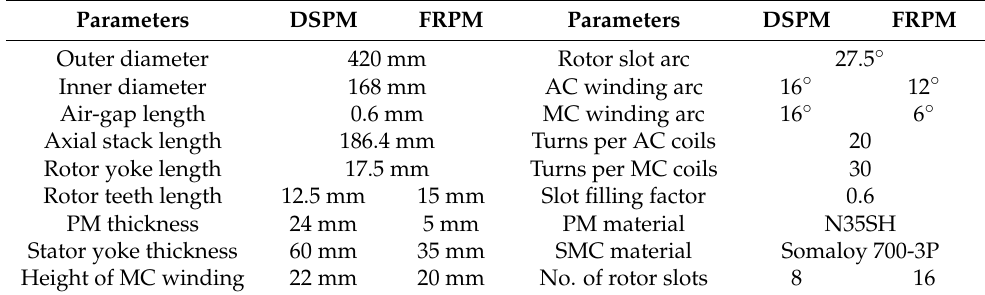
Table 1. Design specifications and parameters.